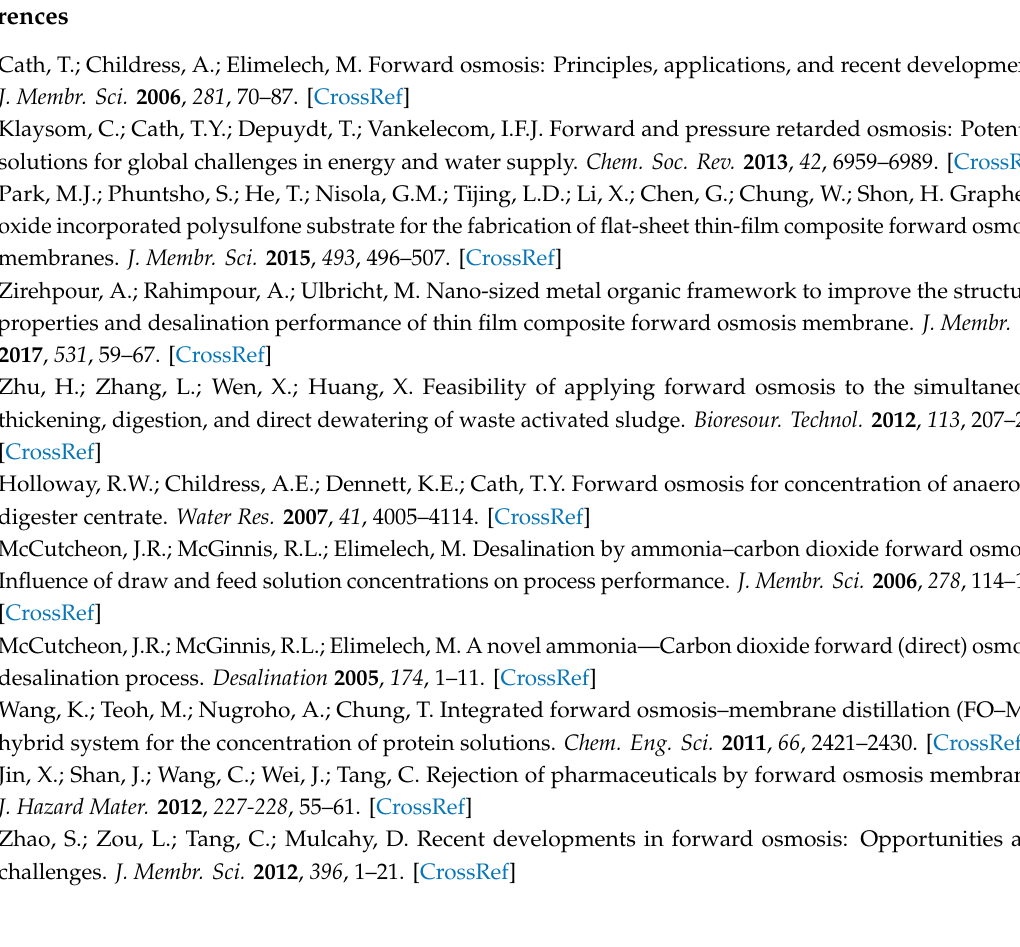
Figure S1: Surface AFM morphology of MCE / CNTs 10 support layer. Figure S2: Cross-section SEM images of MCE / CNTs support layers. Figure S3: Cross-section SEM images of SWCNTs interlayer with the loading of 0.53 g m − 2 . Figure S4: Cross-section SEM images of TFC membrane with SWCNTs interlayer of di ff erent loading. Figure S5: XPS survey spectrum of TFC membrane. Table S1: Chemical species and composition of TFC membrane analyzed using